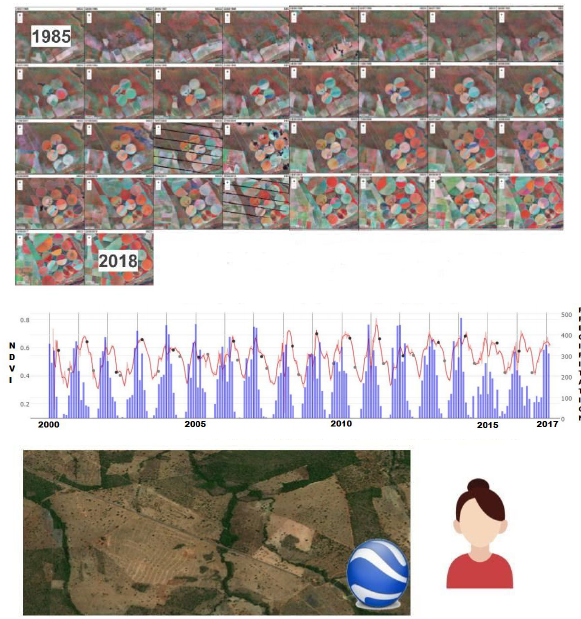
Figure 2. Example of using TVI - Temporal Visual Inspection